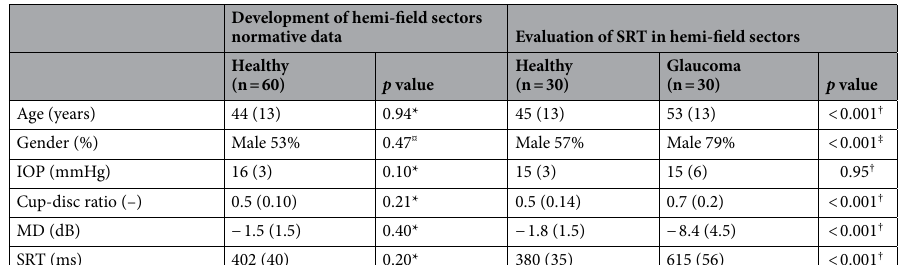
Table 3. Demographics and data summary of the development of hemi-field sectors normative data in EMP and evaluation of SRT in hemi-field sectors study population. Data expressed as mean (SD); Type I error was kept at 5% level and two-tailed tests were used. IOP, intra-ocular pressure in mmHg; MD, mean deviation from standard automated perimetry in decibel (dB); SRT, saccadic reaction time from eye movement perimetry in milliseconds (ms). *Independent T-test between healthy eye from development and evaluation phase. ¤ Chi- square test for proportion of male and female between the groups. † Independent T test for the evaluation phase of the study population of normal and glaucoma 30 in each group. ‡ Chi-square test for proportion of male and female between the groups.